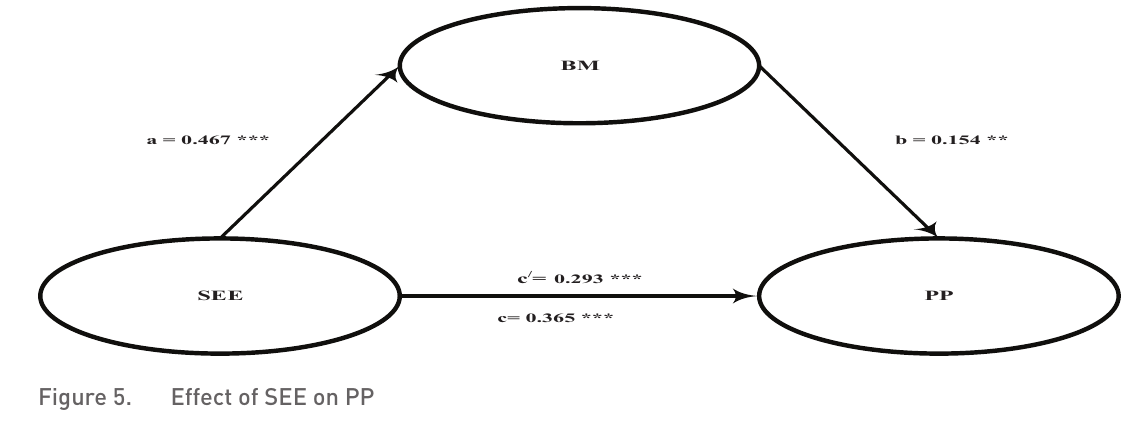
Figure 5. Effect of SEE on